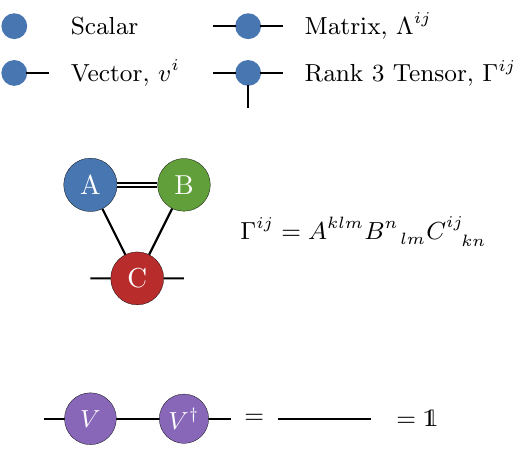
Figure 1 . Top panel shows the Penrose representation of the basic tensor forms such as scalar, vector, matrix and a rank tree tensor. Bottom two panels shows two examples of tensor operations where first notation shows tensor contraction between two rank tree ( A klm and B n rank four tensor ( C ij ) resulting a rank two tensor ( Γ ij ). The bottom equations shows a tensor kn contraction of a isometric tensor V which leads to